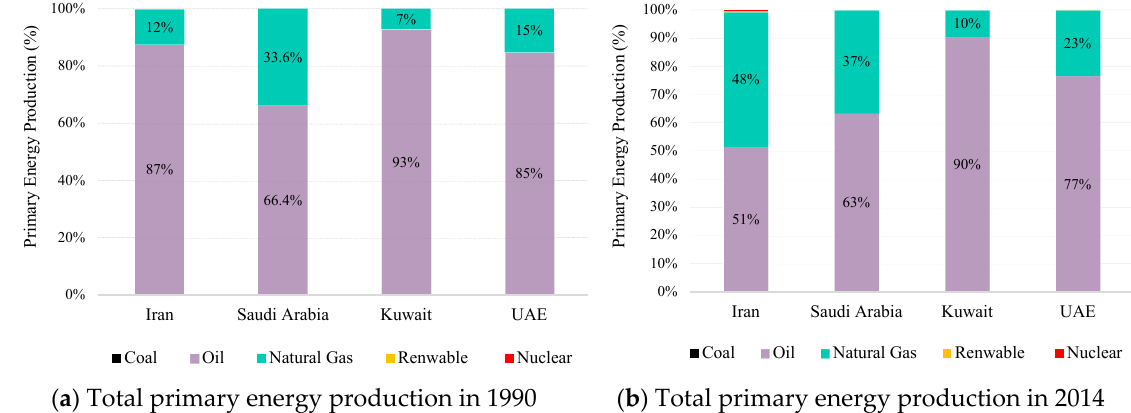
Figure 3. (a ) Primary energy production by energy source in 1990; ( b ) primary energy production in 2014. Based on data from [21,22,24].